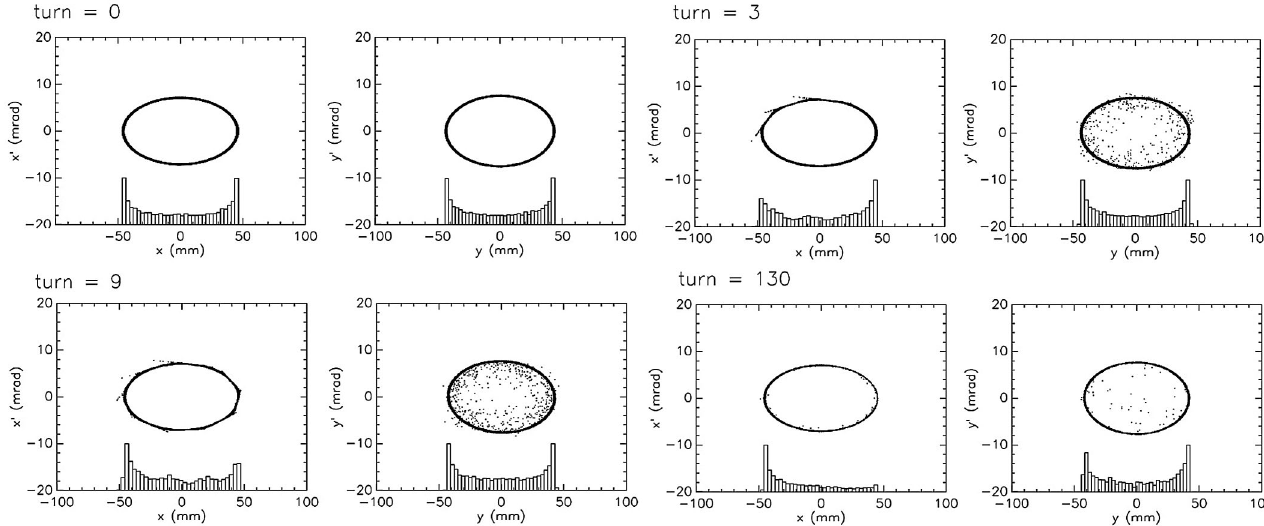
FIG. 6. Beam distributions at the middle point of the dispersion-free long straight section at different turns during the halo collimation of a correlated beam at 80 MeV ( (cid:1) ¼ (cid:1) 1 : 03% ).